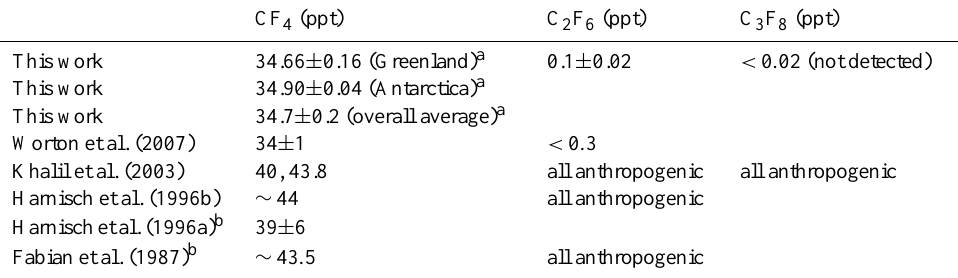
Table 2. Estimates of natural portions of accumulated atmospheric CF 4 , C 2 F 6 , and C 3 F 8 .